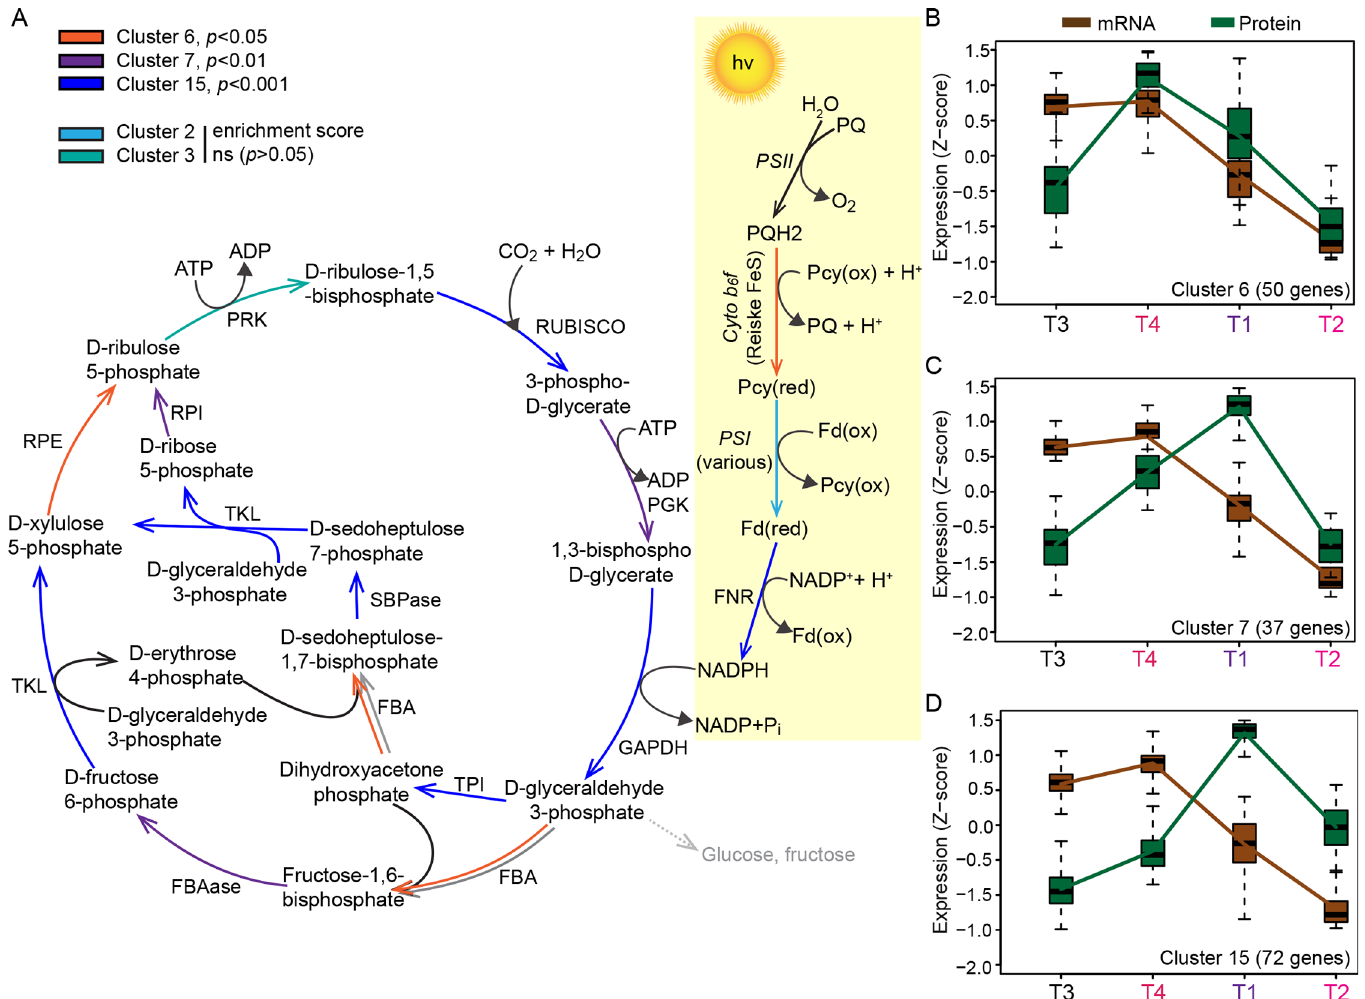
Fig 4. Coverage of the Oxygenic Photosynthesis (OP) Pathway by the joint expression clusters. (A) Cartoon of the OP pathway, with selected interactions color-coded to indicate cluster membership. Light-dependent reactions are indicated by yellow background. Of the 17 interactions in the pathway, 15 were mediated by genes in the high confidence data set (Tables E-G in S1 File). Note that within the light-independent reactions of the Calvin- Bensen-Bassham Cycle we identified two fructose-bisphosphate aldolase (FBA) proteins, wlab.223910 (Class I, Cluster 6) and wlab.149815 (Class II, Cluster 3), both with predicted chloroplast transit peptides. The Class II FBA of the cyanobacterium Synechococcus shows higher reactivity for sedoheptulose-1,7-bisphosphate than for fructose-1,6-bisphosphate than its Class I FBA [94] and thus, although they have not been experimentally characterized, the M . pusilla FBAs depicted here may also partition within the pathway. (B) Joint mRNA and protein expression profiles of the clusters enriched with OP pathway genes (Clusters 6, 7, & 15). Cluster 6 displays considerable correlation (R 2 = 0.643) between the mRNA and protein expression patterns, while Cluster 7 and 15 display either marginal (R = 0.161) or inverse (-0.446) correlation. Profiles for Clusters 2 and 3 are show in Figure P in S1